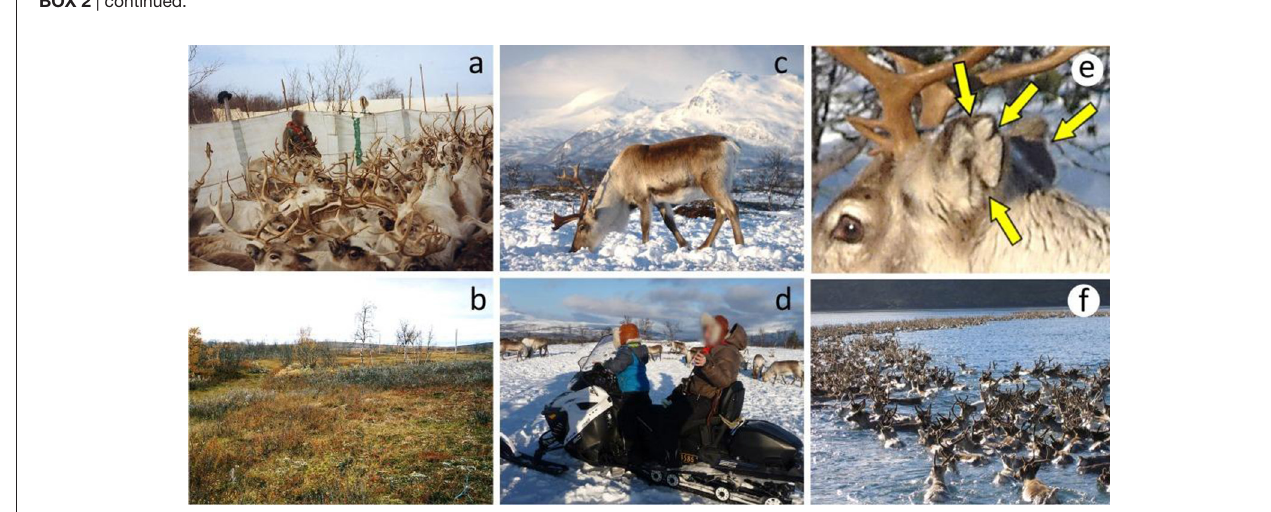
FIGURE 4 | Saami reindeer pastoralism in Norway. (a) The late Mathis Aslaksen Sara with his family’s reindeer in a temporary paddock at Cuovddatmohkki ( Figure 7 ). This paddock was erected in April (2002) to enable his and another family to separate their herds which, after wintering together, were about to move independently to their summer pasture on the island of Magerøya ( Figure 7 ). (b) The same site 5 months later (September 2002): virtually no trace remains either of the paddock or of the presence of the hundreds of reindeer which had been gathered in it. Grazing rights accrue through the legal principle of ‘use since time immemorial’ (Norwegian: alders tids bruk ) but, as photograph (b) shows, it may be no simple matter for pastoralists to document their use of an area. (c) A pregnant reindeer on winter pasture in northern Norway. The snow all around the animal has been excavated by reindeer which have been feeding on the plants beneath. (d) Reindeer herder and her son inspecting their herd in the same area. (e) Ear marks (yellow arrows) permanently and indelibly identify the ownership of every reindeer in a herd. Each owner has his or her own unique pattern of marks which are cut into the left and right ears of animals in their first summer and which they bear for life (see Paine, 1994, p. 24; Beach, 2007). (f) Transhumant pastoralism: 3,000 reindeer swim in September (2004) from their summer pasture on the island of Magerøya to the mainland at the start of their 200km autumn migration to winter pasture south of Cuovddatmohkki on Finnmarksvidda ( Figure 7 ). Magerøya Sound is ∼ 1,200m wide at this point. Photographs: Nicholas Tyler.